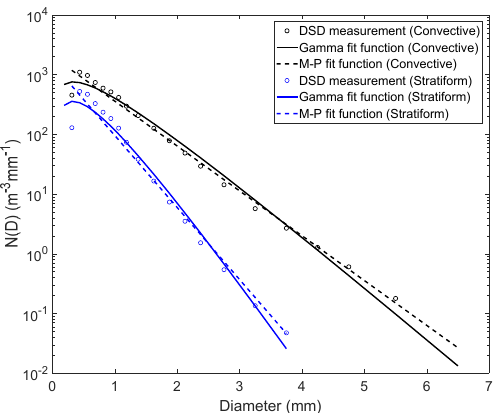
Figure 3. Composite raindrop spectra for convective and stratiform samples (circles). The gamma functions fitted on each spectrum using the non-linear least square estimation method (solid lines). The Marshall Palmer (M-P) functions fitted on each spectrum (dashed lines).